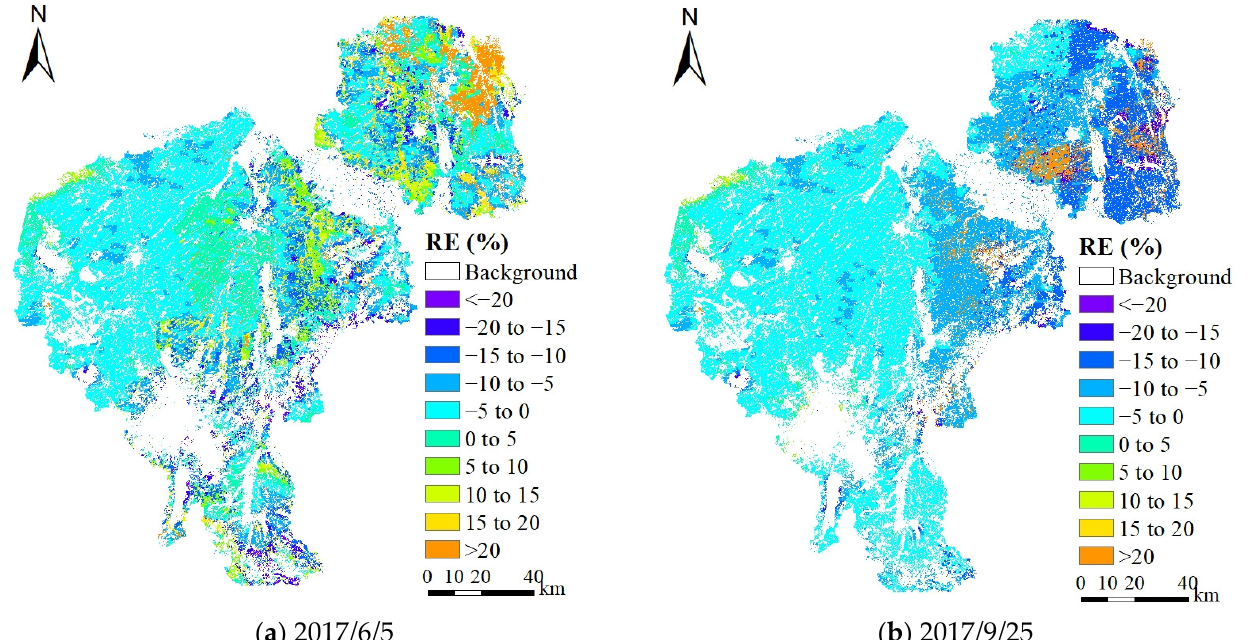
Figure 7. Maps of RE values of LST (30 m) between Landsat 8 and MOD11A1 resample products.